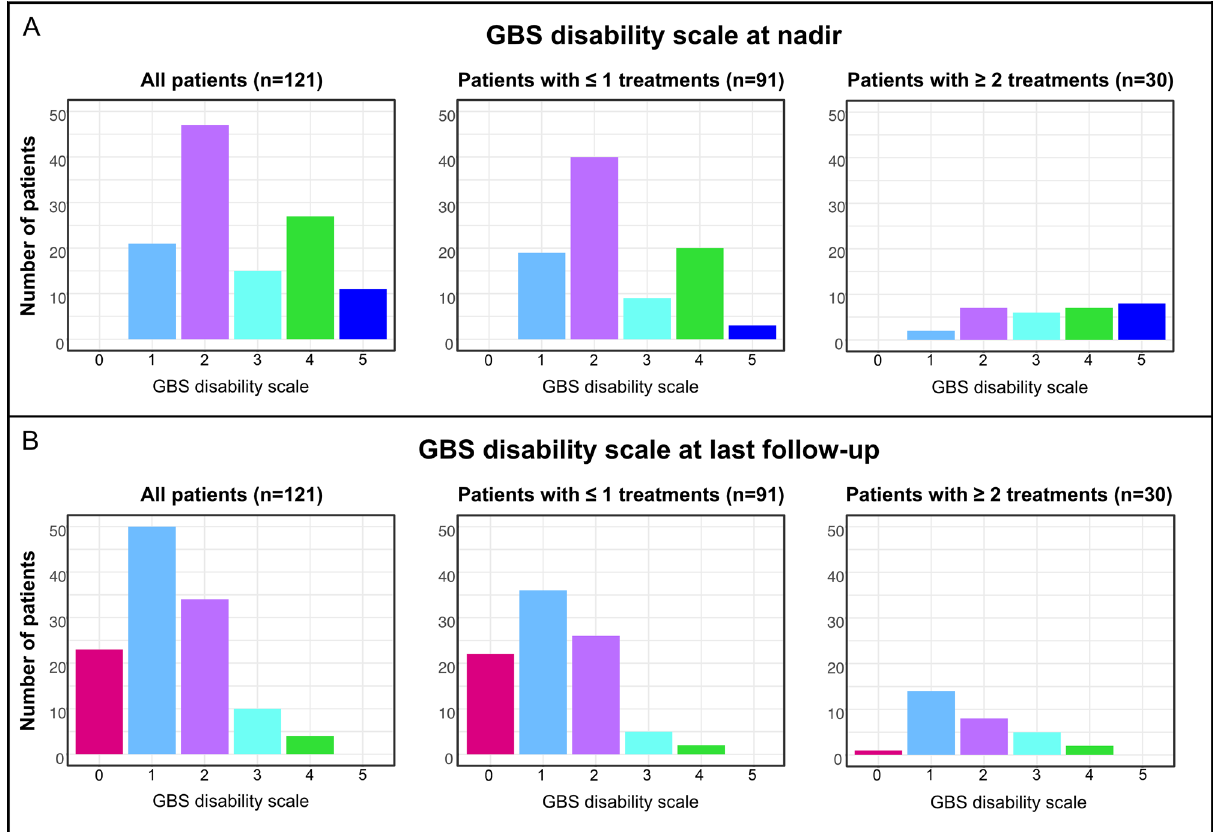
Figure 3. GBS disability scale. Number of patients in each GBS disability scale category (ranging from 0 to 6 with higher scores indicating more severe disease) at nadir ( A ) and last follow-up ( B ). Barplots are shown for all patients and for patient groups according to number of treatments (zero or one vs. two or more treatments). The GBS disability score of 6 is not displayed as no patient died during the